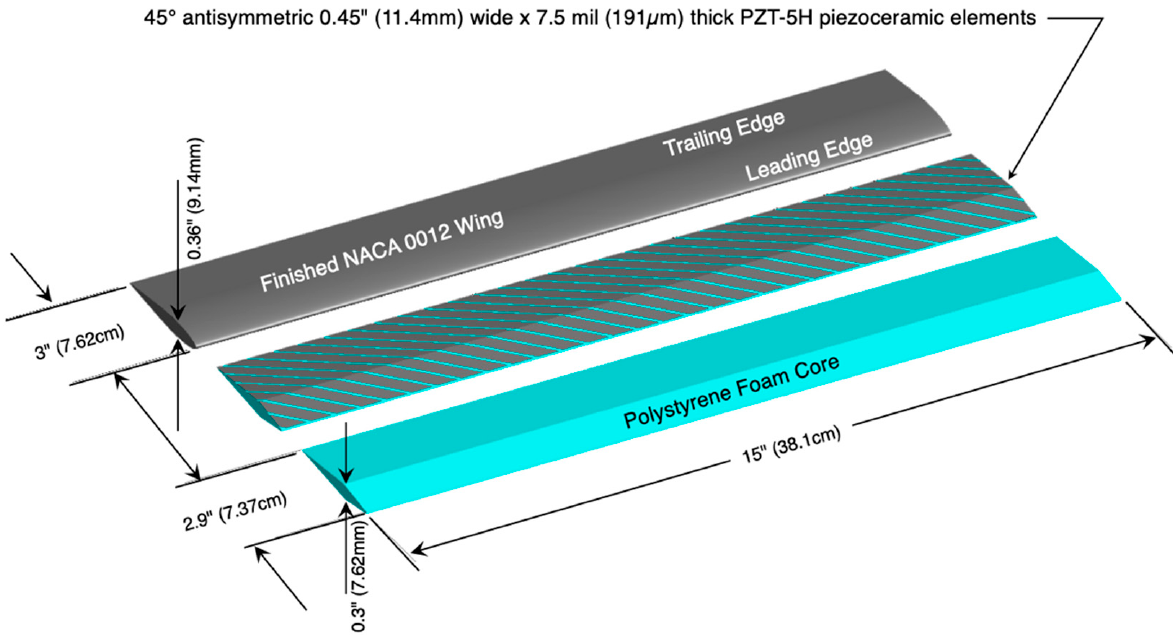
Figure 5. DAP wing build geometry and internal structural layout.